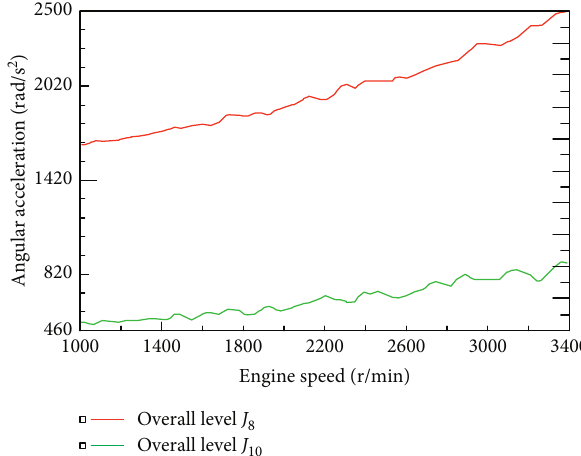
Figure 33: The overall angular acceleration curves of the primary flywheel and the input shaft of the gearbox matching the DMF with the bifilar CPVA under driving conditions.